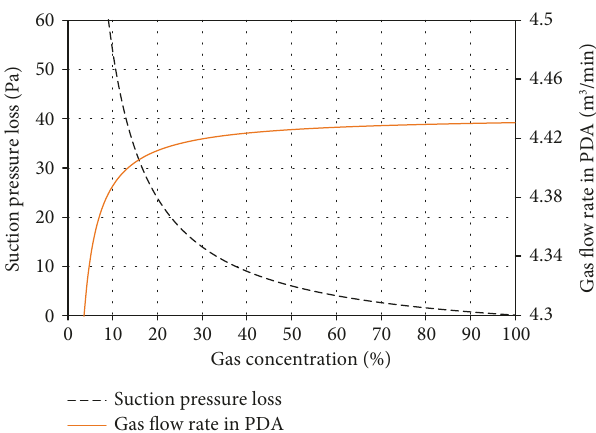
Figure 5: Curves of suction pressure loss caused by air leakage through the 52nd group of boreholes and the gas fl ow rate in the plastic deformation area (PDA) under di ff erent